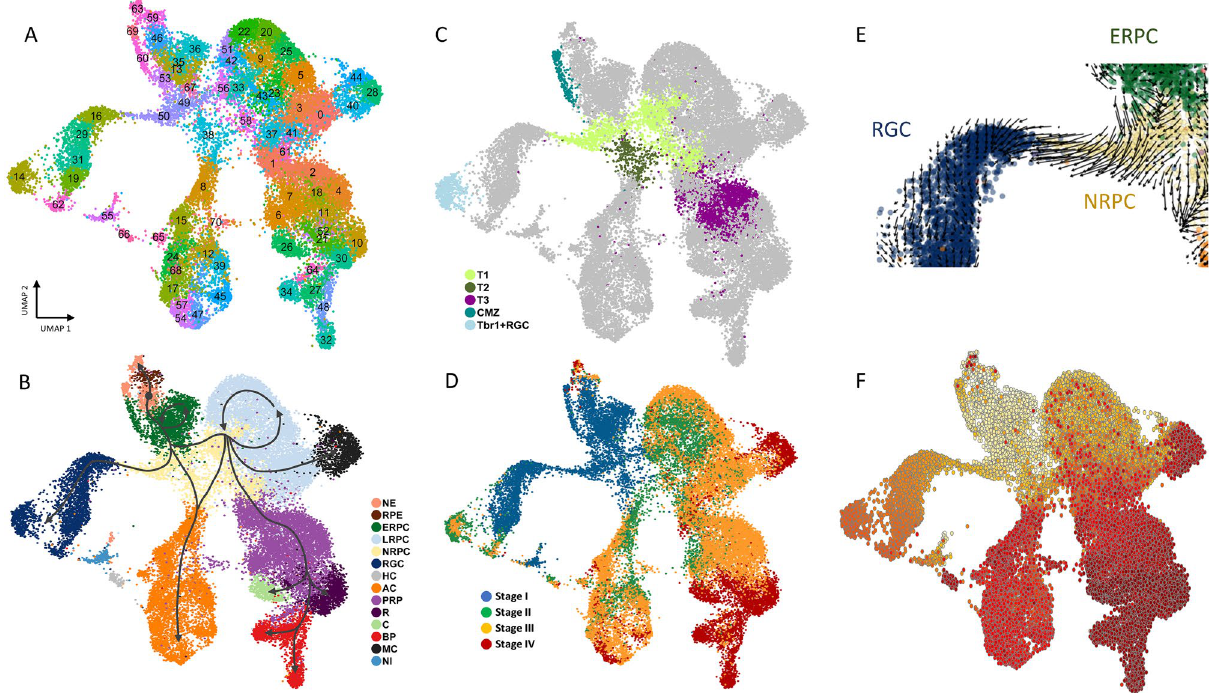
Figure 1. Joint scRNA-Seq-based UMAP of 38,091 cells corresponding to four developmental stages of native (NaR) and iPSC-derived retinal organoids (RO). ( A ) 2D UMAP manifold showing NaR and RO cells jointly and their assignment to 71 clusters by k-means clustering. ( B ) Merging the clusters in 13 major retinal cell types corresponding to neuroepithelium (NE), retinal pigmented epithelium (RPE), early (ERPC), late (LRPC), neurogenic retinal progenitor cells (NRPC), retinal ganglion cells (RGC), horizontal cells (HC), amacrine cells (AC), photoreceptor precursor cells (PRP), cones (C), rods (R), bipolar cells (BP), and Müller cells (MC), and cell-type not-identified (NI) on the basis of the expression of known marker genes (Fig. S2, Table S3). Information from temporal sampling, 3D UMAP manifolds (http:// www. sig. hec. ulg. ac. be/ giga), pseudo-time and RNA velocity analyses was combined and summarized graphically by the trajectories shown as dark grey arrows in ( B ). The grey dot within NE marks the origin or root of the trajectories. ( C ) Identifying known retinal sub-populations: post-mitotic transitional precursor cell populations (T1, T2, T3) 21 , Ciliary Marginal Zone (CMZ) 31 , and Tbr1 + retinal ganglionic cells (Trb1 + RGC) 32 . ( D ) Cells colored by developmental stage: I. blue = DD13 + E13, II. green = DD21 + P0, III. orange = DD25 + P5, IV. red = DD29 + P9. ( E ) Cell-specific RNA velocities 15 confirming the ERPC → NRPC (T1) → RGC cellular trajectory. ( F ) Velocity-based diffusion pseudo- time analysis using a velocity-inferred transition matrix 14 . Increase in pseudo-time is marked by increase in